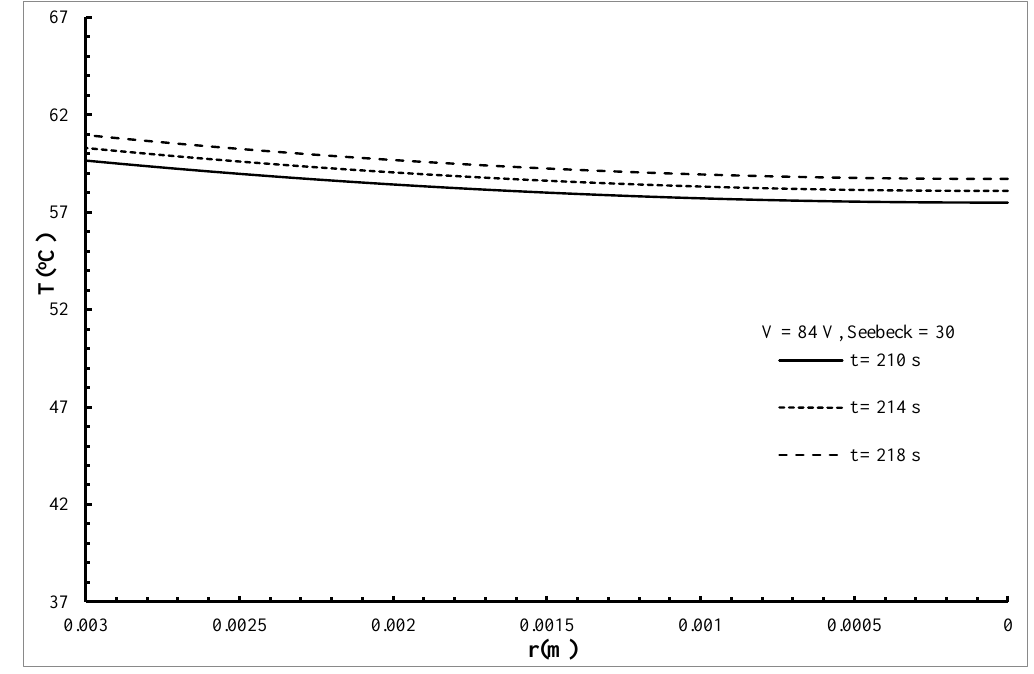
Figure 9 . The absolute temperature distribution of liposarcoma tumor with various values of time R   . when 600 e